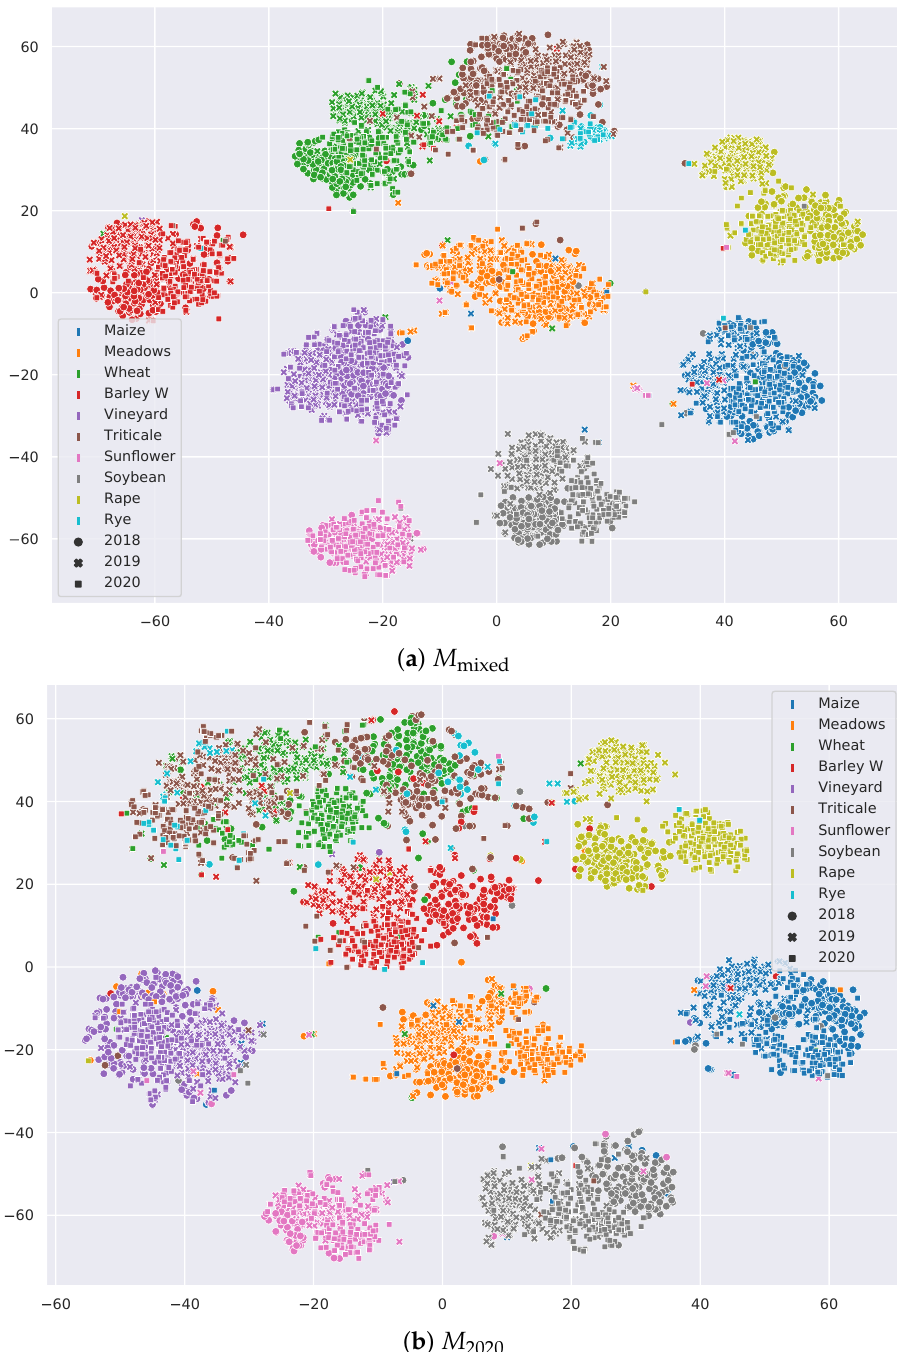
Figure 6. Learned Representations. Illustrations of the learned SITS representations of the mixed- year model M mixed ( a ) and the specialized M 2020 ( b ). T-SNE algorithm is used to plot in 2D the representation for 100 parcels over 10 classes and 3 years. We observe that M mixed produced cluster of embeddings that are consistent from one year to another, and with clearer demarcation between